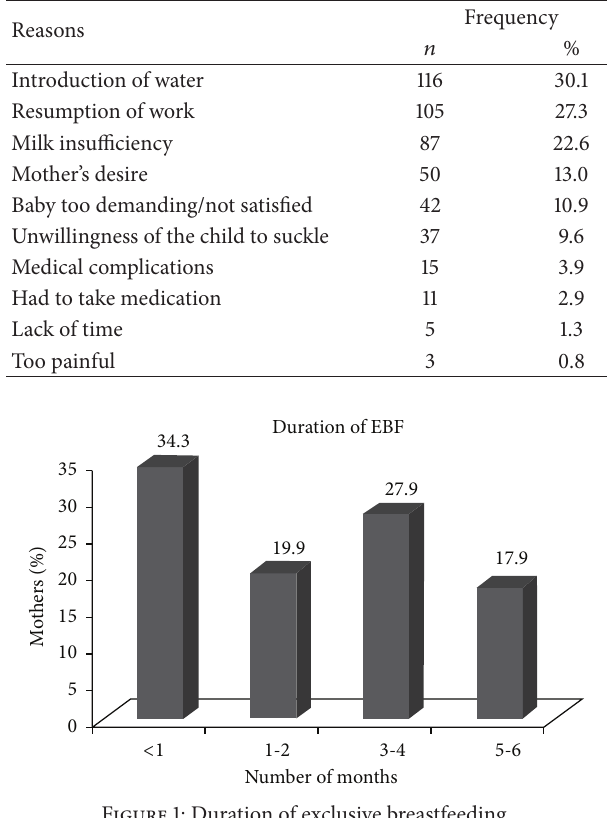
Table 1: Reasons for not adhering to the WHO recommendations of exclusive breastfeeding for the first six months.